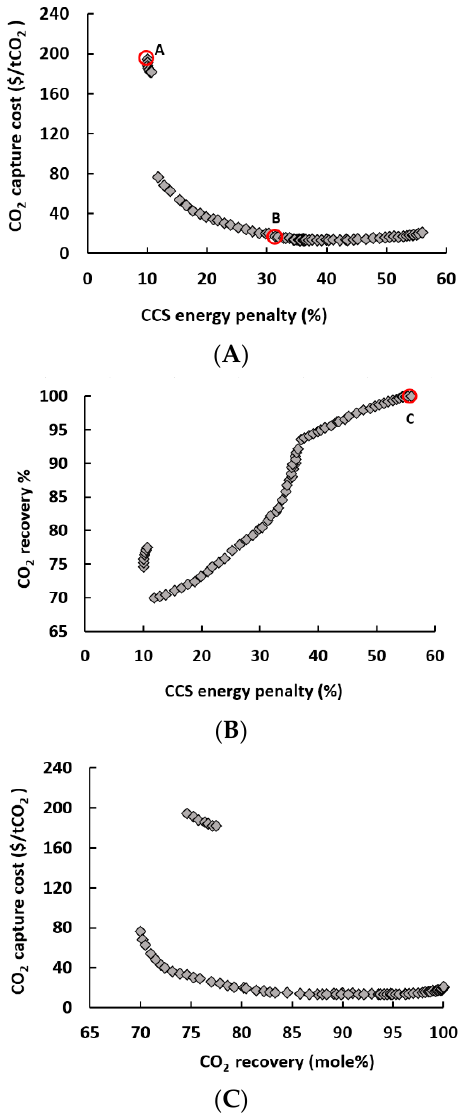
Figure 6. Pareto solutions set obtained from process optimization ( A ) CO 2 Capture Cost vs. CCS Energy Penalty (%) ( B ) CO 2 Recovery (%) vs. CCS Energy Penalty (%) ( C ) CO 2 Capture Cost vs. CO 2 Recovery (%)